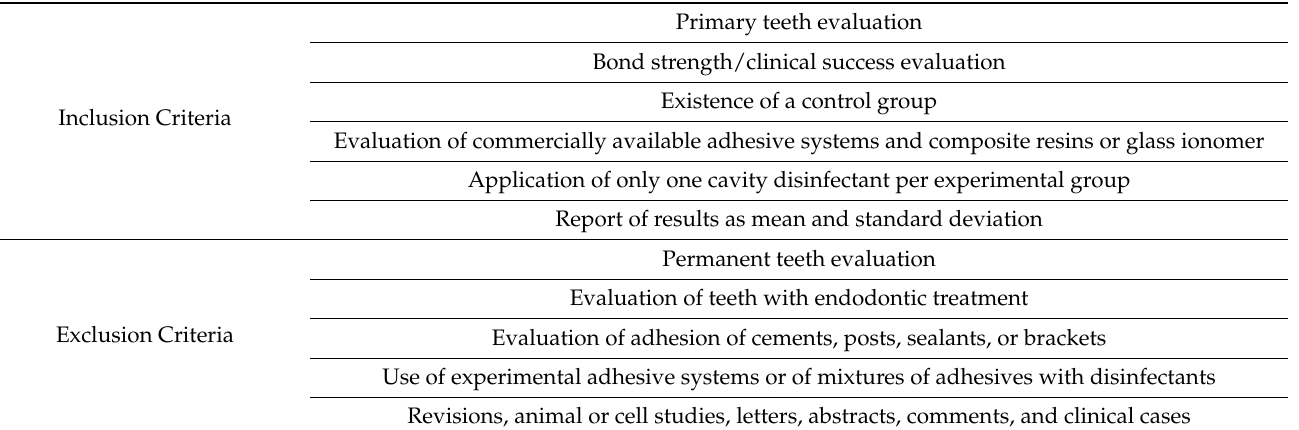
Table 4. Inclusion and Exclusion